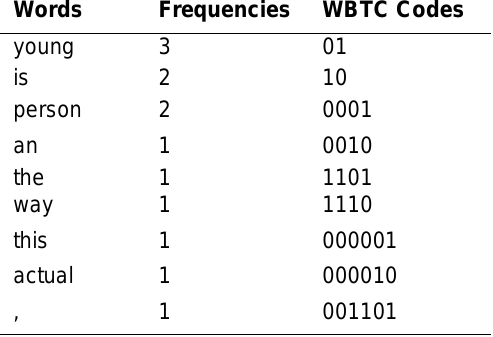
Table 4: Word-based Tagged Code for each word